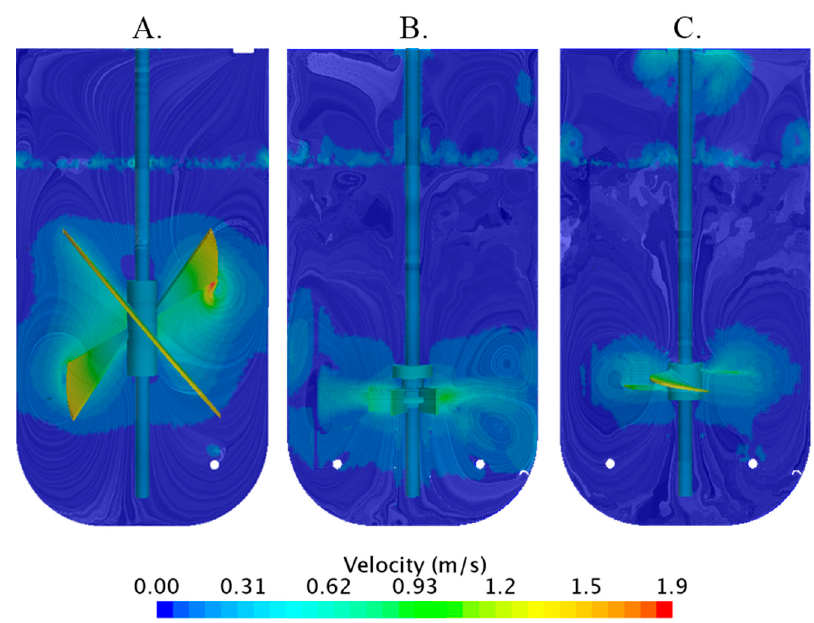
Figure 6. Flow patterns for Brunswick Bioflo / CelliGen 115 bioreactor at 250 RPM and 2.5 l min − 1 for: ( A ) inclined paddles; ( B ) Rushton; and ( C ) propeller.